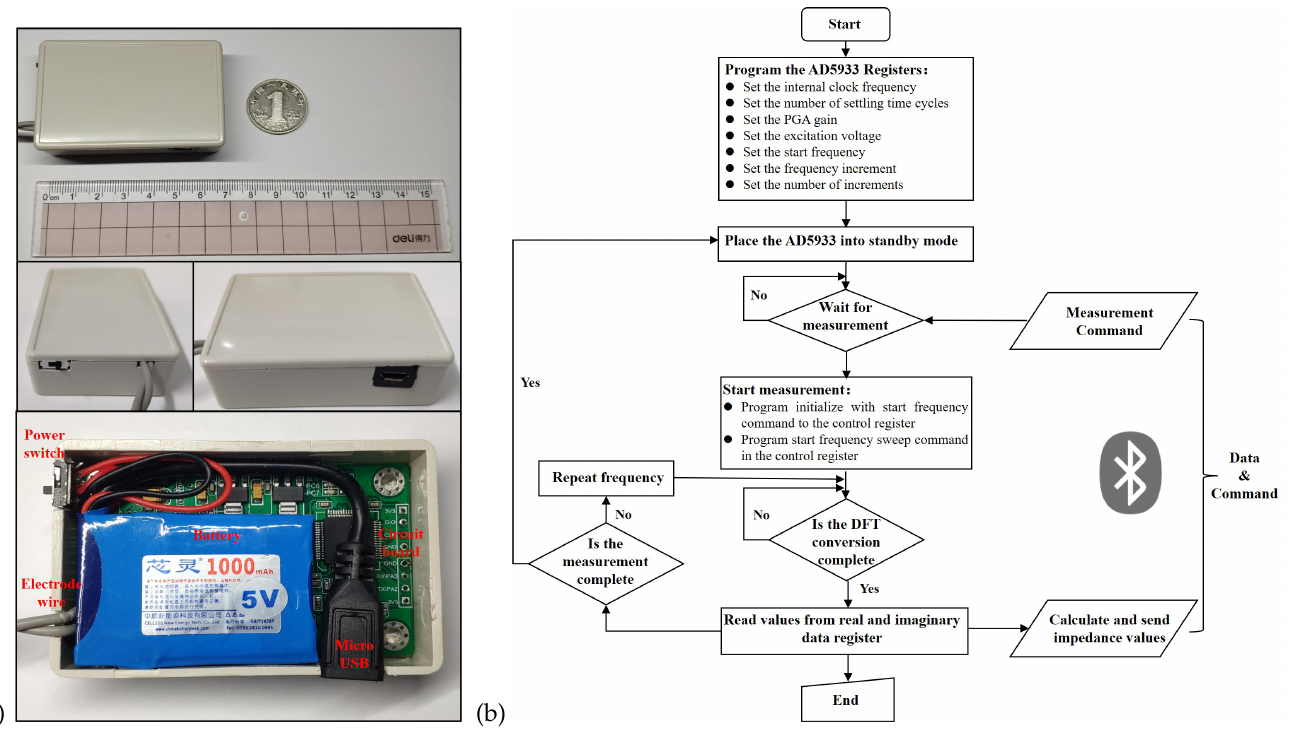
Figure 5. Display of electronic devices and software flow chart: ( a ) The physical diagram of the electronic device; ( b ) The flow chart of the embedded